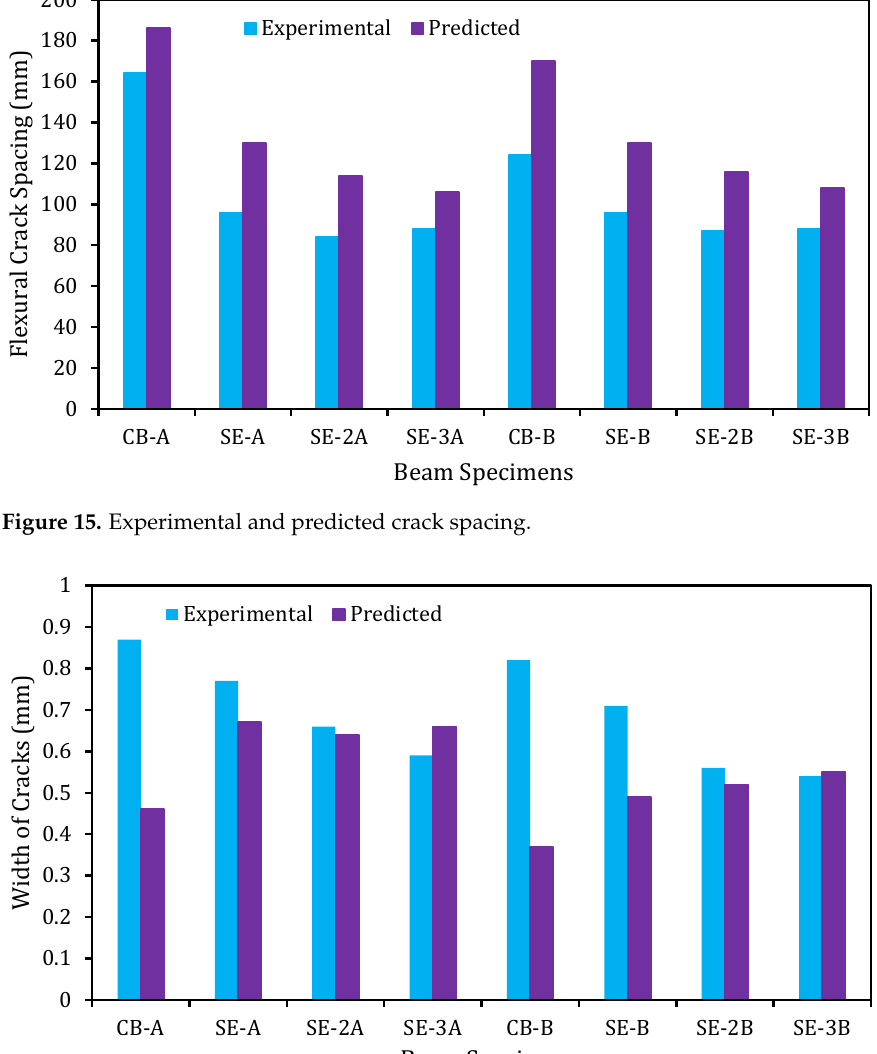
21 of 27 Figure 14. Experimental and predicted ultimate load comparison.